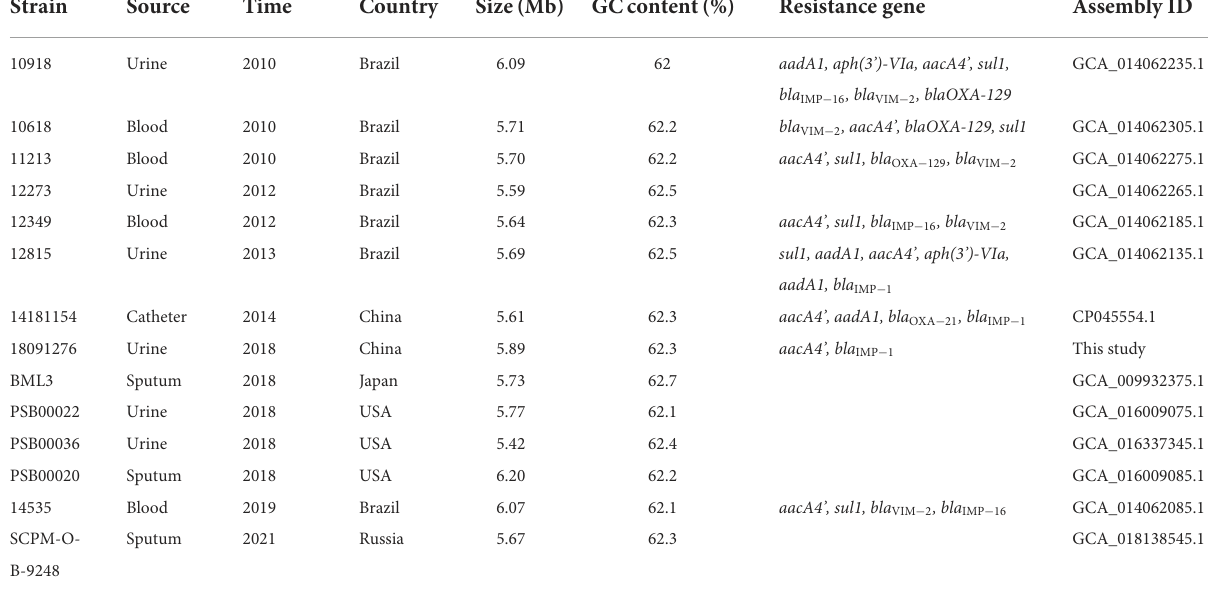
TABLE 2 The information of P. juntendi